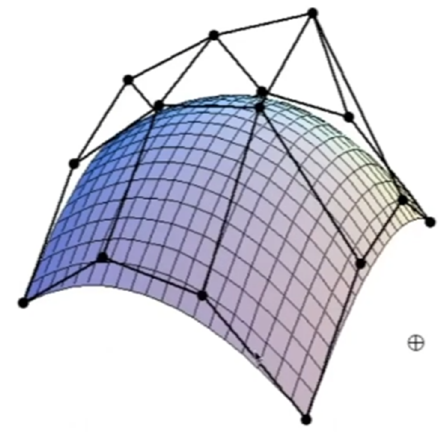
Figure 4. NURBS surface reconstruction topology optimization design.